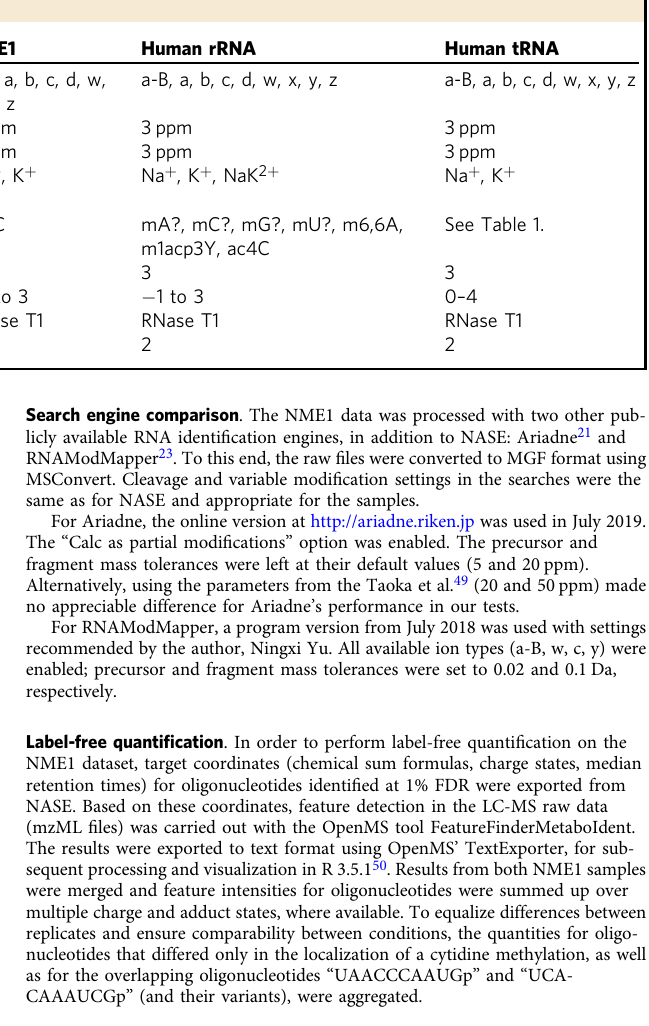
Table 2 Parameters for NASE searches of different